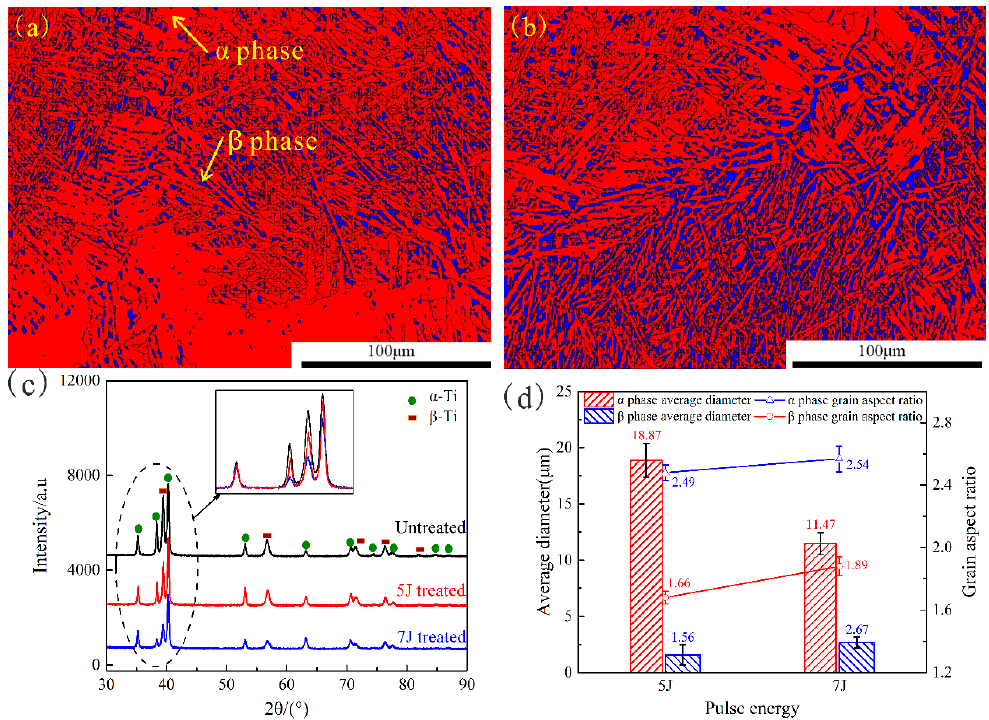
Figure 5. The electron backscatter diffraction (EBSD) phase maps for 5 J ( a ) and 7 J ( b ) treated samples, X-ray diffraction (XRD) patterns of three test samples ( c ); and average diameter and grain aspect ratio of both treated samples ( d ).